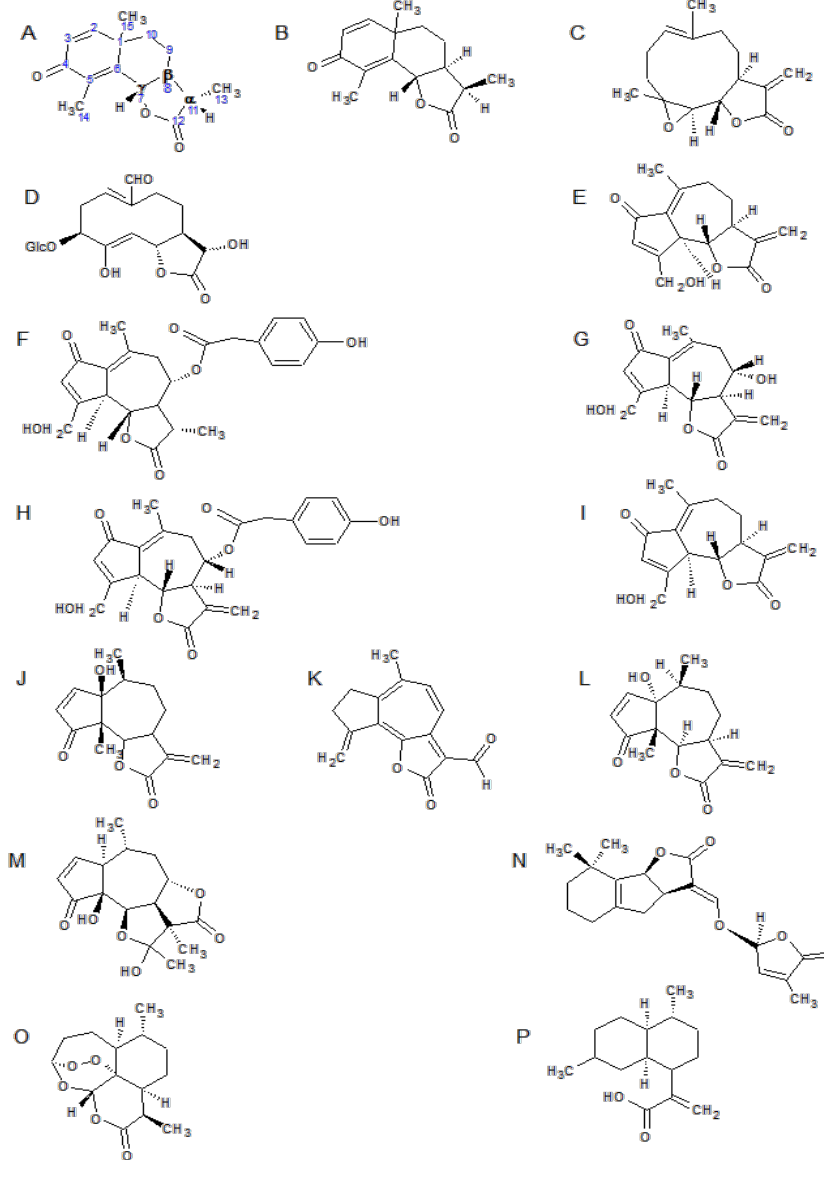
Figure 1. Structures of compounds referred to within the text, arranged by their structural classifications. Eudesmanolides α-santonin ( A ), β-santonin ( B ), germacranolides; Parthenolide ( C ), Lactuside A ( D ), guaianolides; 8-deoxylactucin ( E ), 11.( S ),3-dihydrolactucopicrin ( F ), lactucin ( G ), lactucopicrin ( H ), Pseudoguaianolides; helenalin ( I ), Hymenin ( J ), lettucenin A ( K ), parthenin ( L ), tenulin ( M ), Strigolactones; 8-deoxy-strigol ( N ) Cadinanolide; Artemisinin ( O ), Seco-cadinanolide; Artemisinic acid ( P ). Labeling system of sesquiterpene lactones is shown on α-santonin ( A ). α-Methyl-γ-lactone ring shown at bottom of picture, with α, β and γ carbons